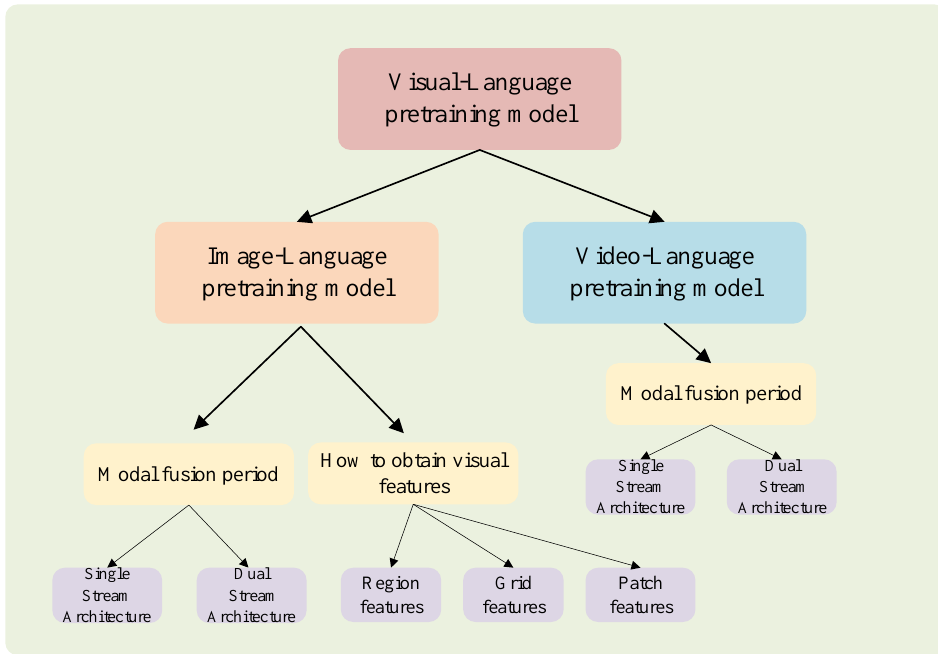
Figure 2. Classification of vision – language pretraining model.